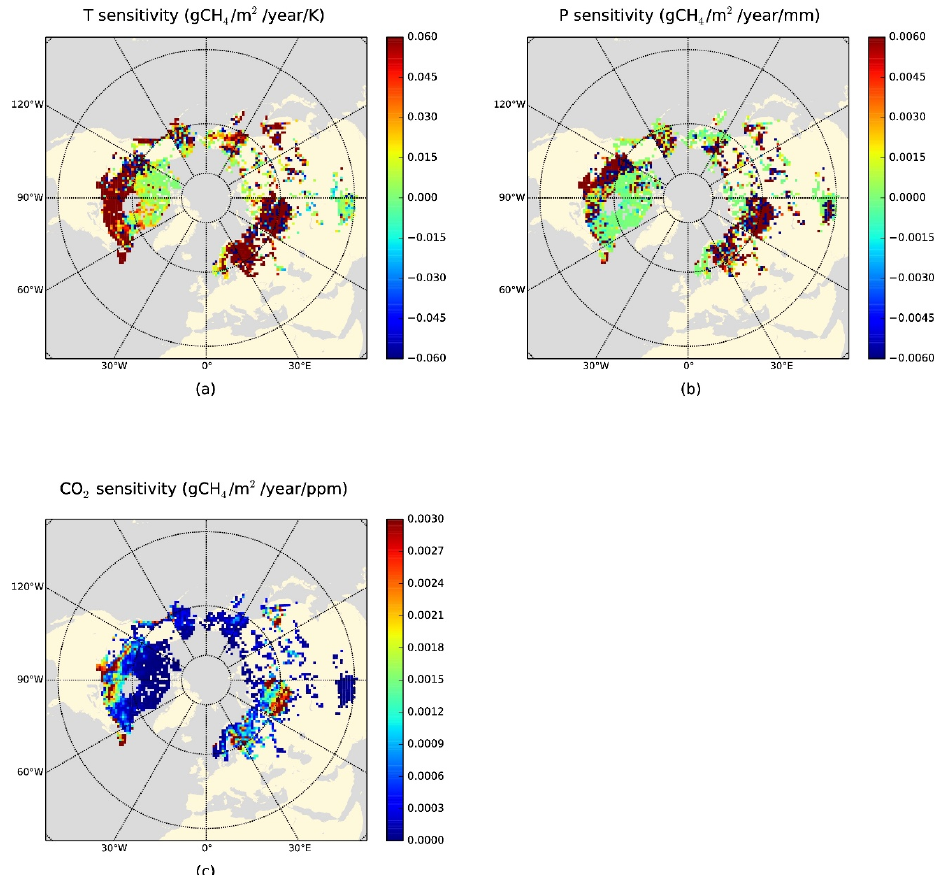
Figure 8. Spatial distributions of sensitivities of CH 4 to climate drivers. Panel (a) : sensitivity to air temperature; panel (b) : sensitivity to precipitation; panel (c) : sensitivity to [CO 2